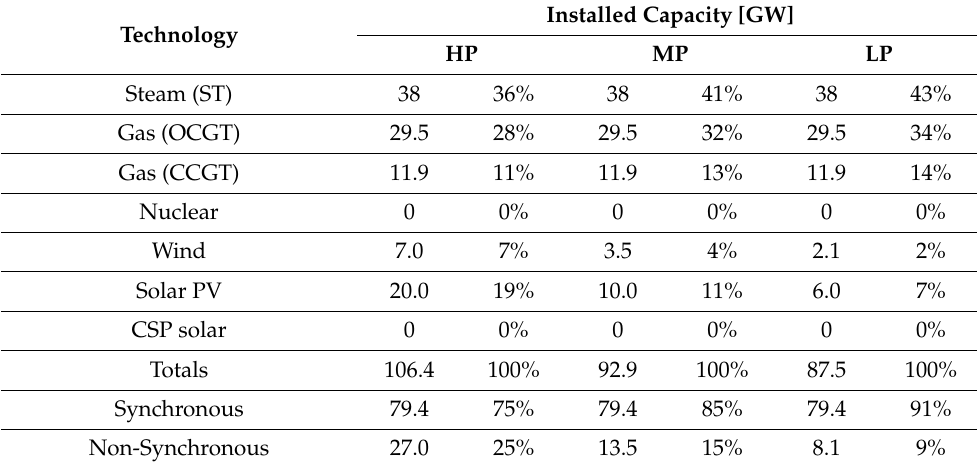
Table 1. Summary of the KSA’s energy mix for 2023.